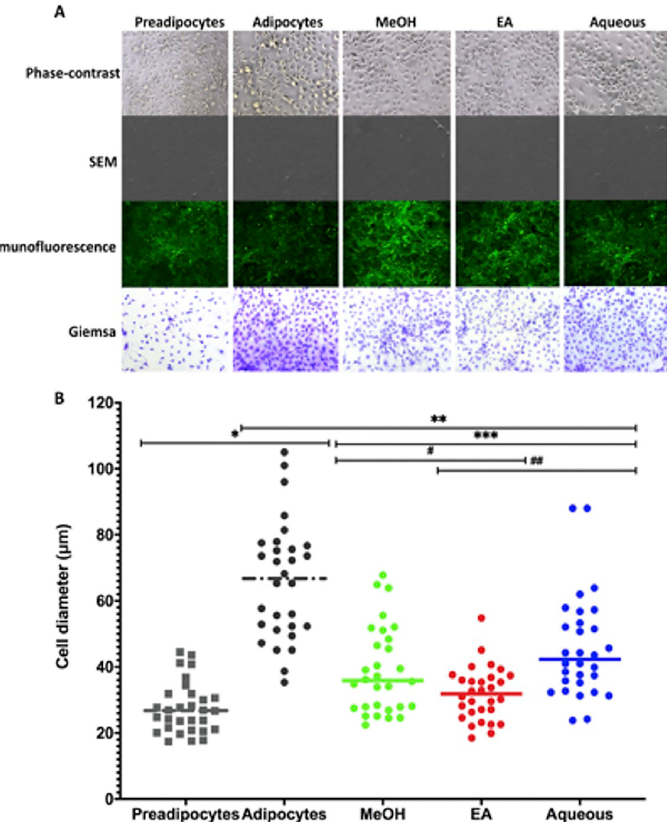
Fig 7. The phase-contrast microscopy, SEM, Immunofluorescence staining and Giemsa staining showing the effect of B . spergulifolius extracts on the cell morphology and diameter of 3T3-L1 adipocytes. A. Cell morphology was evaluated by phase-contrast microscopy, scanning electron microscopy (SEM), immunofluorescence staining and Giemsa staining in preadipocytes, mature adipocytes without B . spergulifolius extracts and adipocytes treated with IC 50 doses of MeOH, EA and Aqueous of B . spergulifolius extracts. Representative images showing changes of cell- morphology after treatment with an IC 50 dose of MeOH, EA and Aqueous of B . spergulifolius extracts for 24 h. The cells were imaged under the phase-contrast microscope at 10X magnification (Scale bar: 100 μ m). The cells were mounted with a thin layer of gold and imaged at 500X using scanning electron microscope (SEM) (Scale bar: 200 μ m). By immunofluorescence with Phalloidin (Alexa Fluor-488), F-Actin was stained and the cells were viewed under confocal microscopy at 5X magnification (Scale bar: 100 μ m). By Giemsa, the cells were stained and viewed under a phase-contrast microscope at 10X magnification (Scale bar: 100 μ m). B. Measurement of cell diameter in images stained with Giemsa. Three wells for each cell group were evaluated. Three distinct-randomly chosen regions in